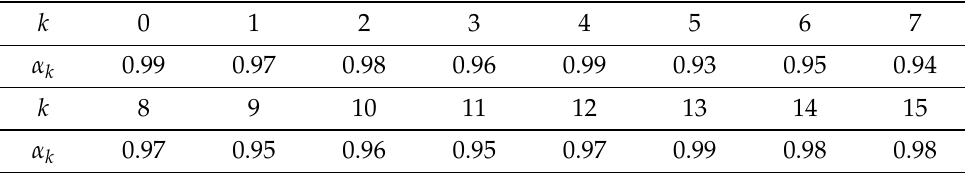
Table 1. The variable orders in System